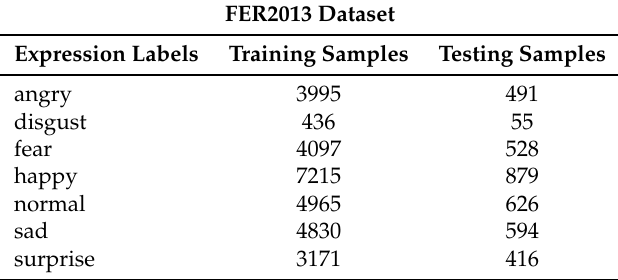
Figure 11. Some images of FER2013 database. From left to right: anger, disgusted, fearful, happy, normal, sad and surprised. Table 2. This table describes the sample number of FER2013